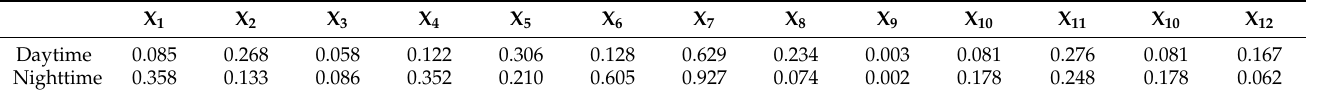
Table 2. The q values of single factors for daytime and nighttime LST.